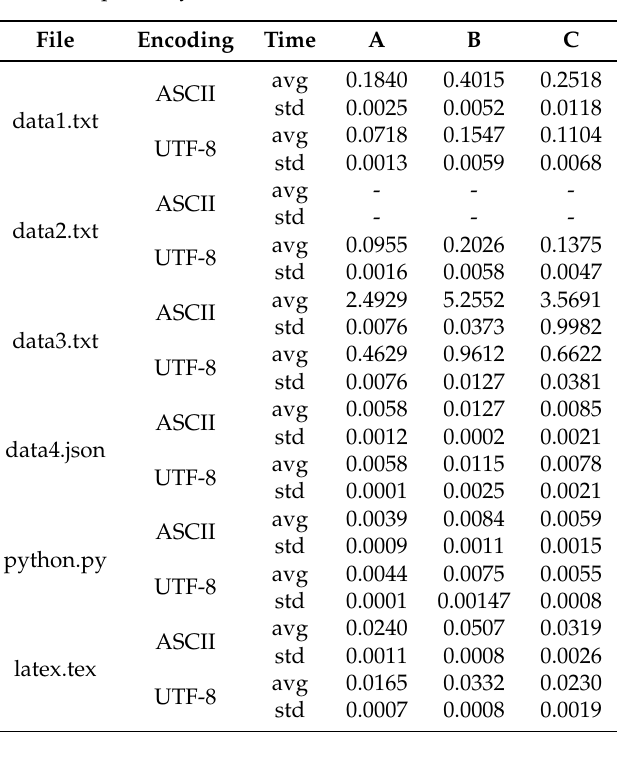
Table 4. The results show the transition times from the image png to the text file. The list of columns includes filename, the time needed to create the text file, PC A, PC B, and PC C. The script has been run 100 times. Avg and std are respectively: mean time and standard